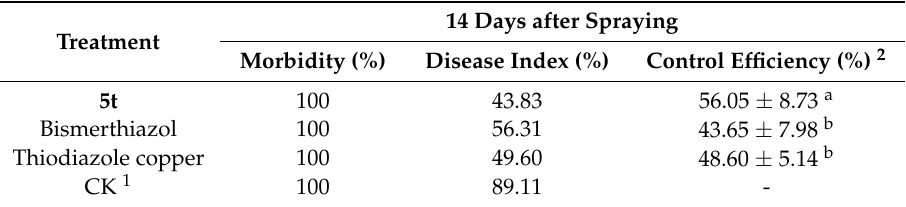
Table 4. Curative activity of compound 5t against rice bacterial leaf blight.